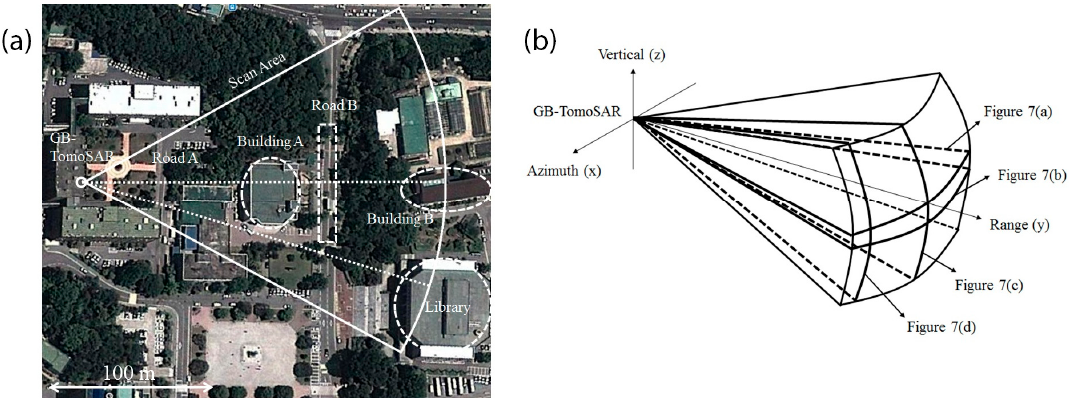
Figure 5. ( a ) Scan area of the GB-TomoSAR experiment overlain by Google Map image and ( b ) 3-D conceptual diagram of image cone.